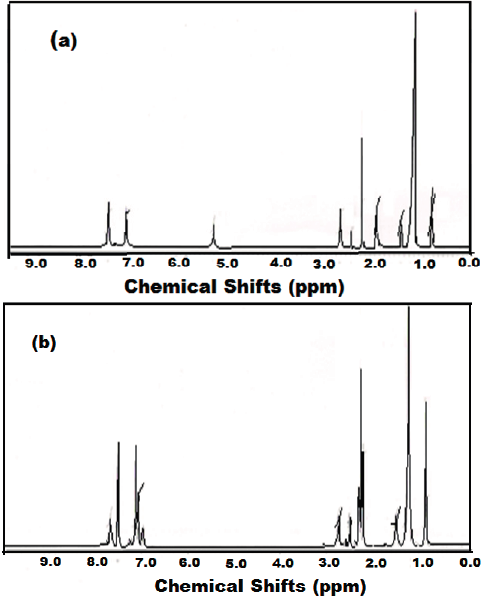
Figure 1. 1 H-NMR spectra of ( a ) OA-TS and ( b )